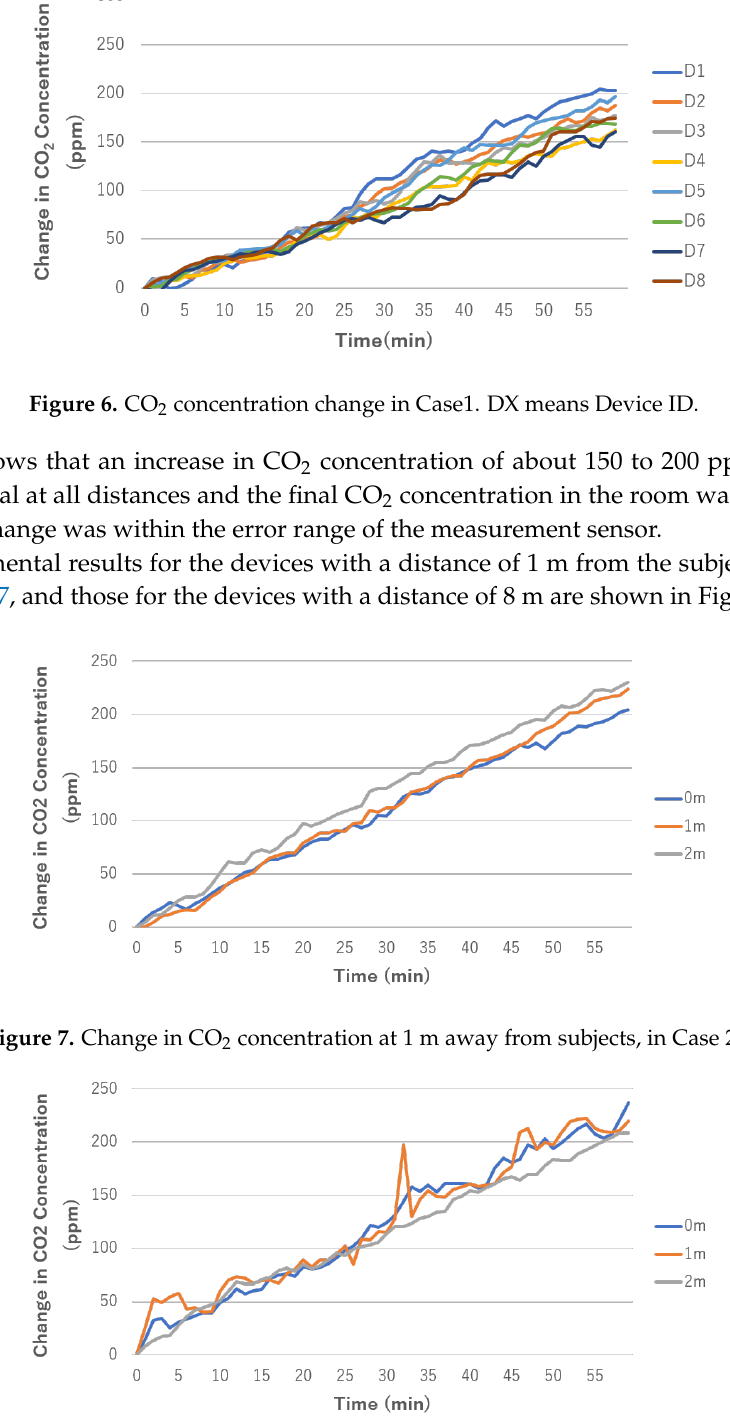
Figure 8. Change in CO 2 concentration at 8 m away from subjects, in Case